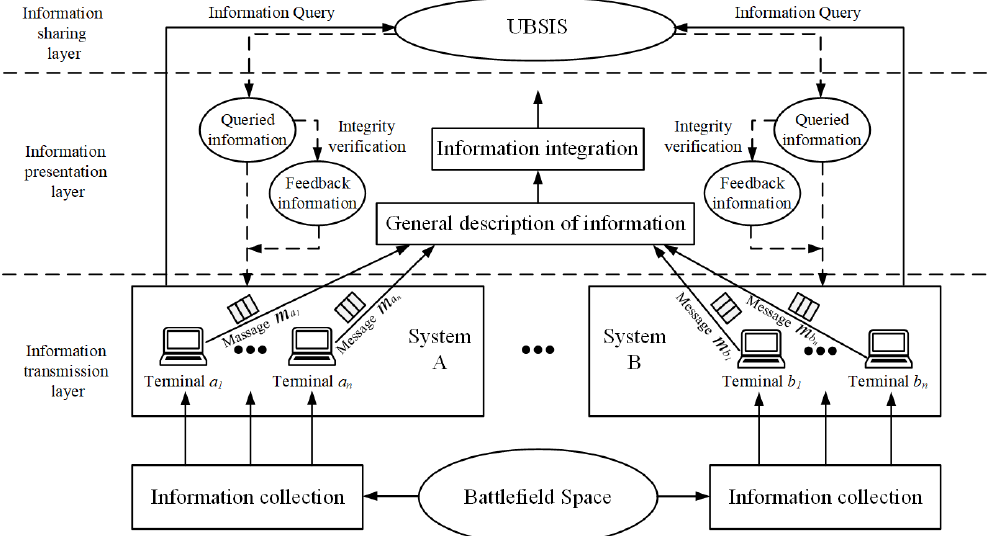
Figure 4. Schematic diagram of information sharing based on a unified information